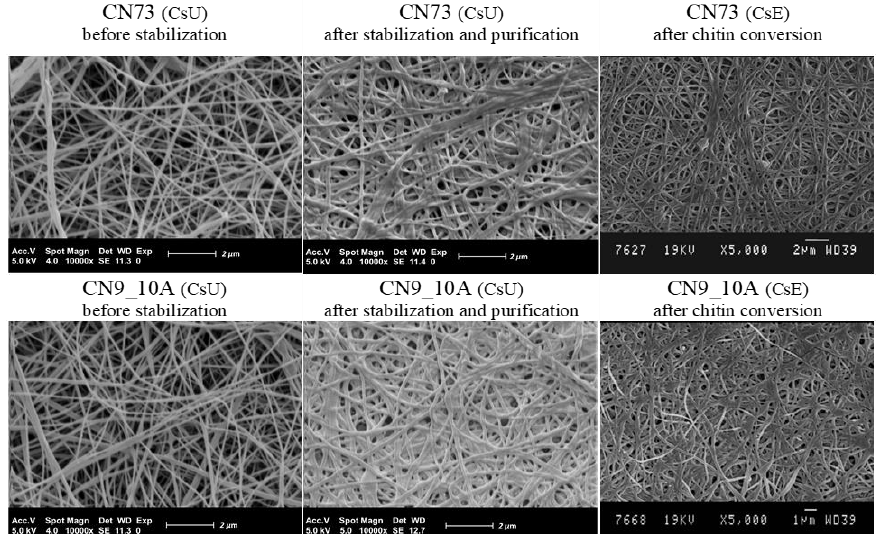
Figure 8. ESEM analysis of electrospun CsU1 and CsU2 mats before, after stabilization and after reacetylation.